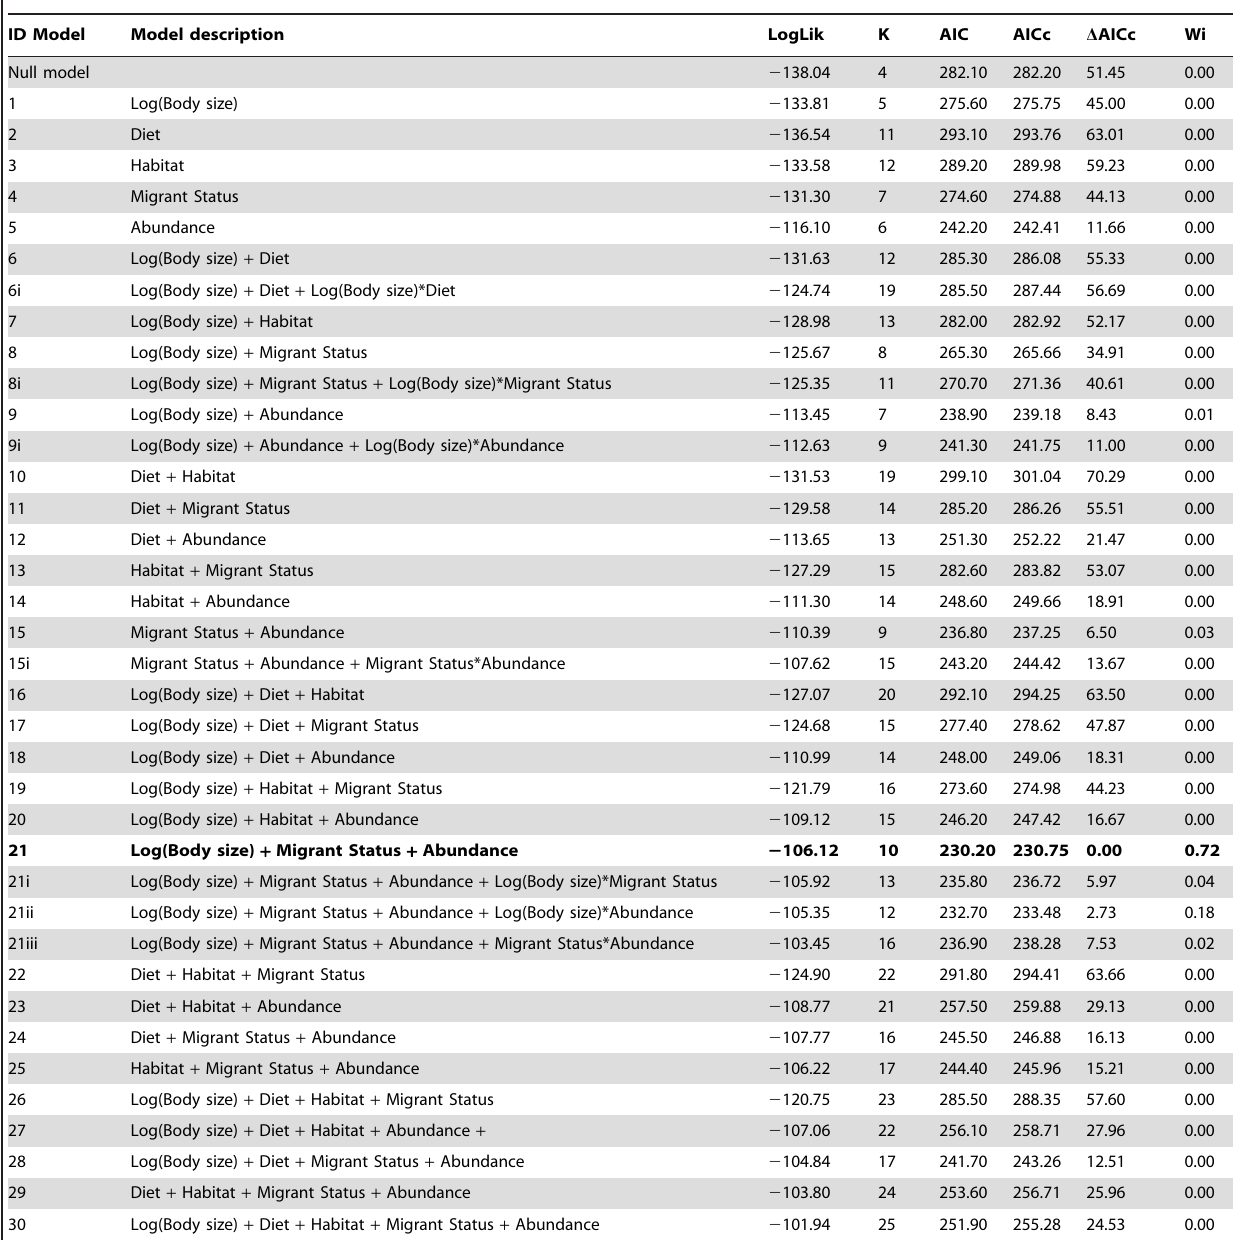
Table 1. Akaike’s criterion (AIC) and the corrected criterion (AICc) for each candidate model explaining the variation in probability of local apparent extinction of birds in China using GLMM Laplace procedure (Link = Logit, Binomial) including log-transformed body size as a continuous, diet ( carnivore , frugivore, granivore, herbivore, insectivore, insectivore-frugivore, granivore-insectivore, omnivore), habitat ( bank , farmland, forest, marsh, open area, scrub, water, woodland), and migrant status ( migrant , resident, summer visitor, winter visitor) as categorical factors, abundance ( common , rare, undetermined) (with italicized class used as reference), and Genus within Family within Order as three nested random